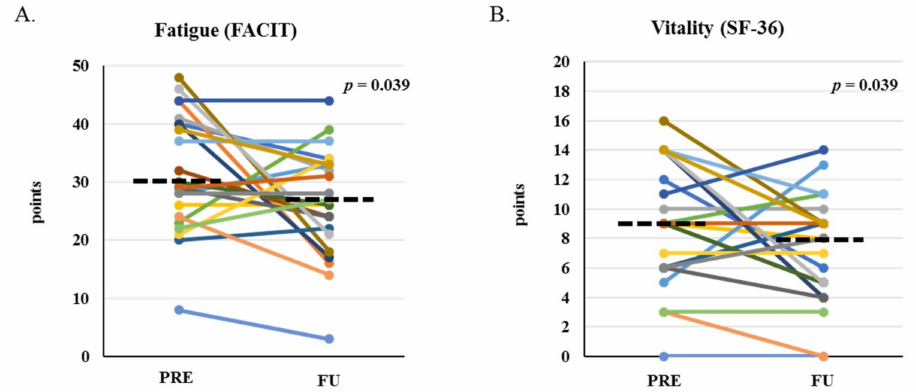
Figure 4. Patient-reported fatigue categories before and one-month after HCT. Patient-reported fatigue as assessed by the fatigue sub-section of Functional Assessment of Chronic Illness Therapy-Fatigue (FACIT-F) ( A ) and vitality sub-section of Health Survey SF-36 ( B ) at PRE and FU. p -values indicate paired-sample comparison between PRE and FU. Dashed lined represent median at PRE and